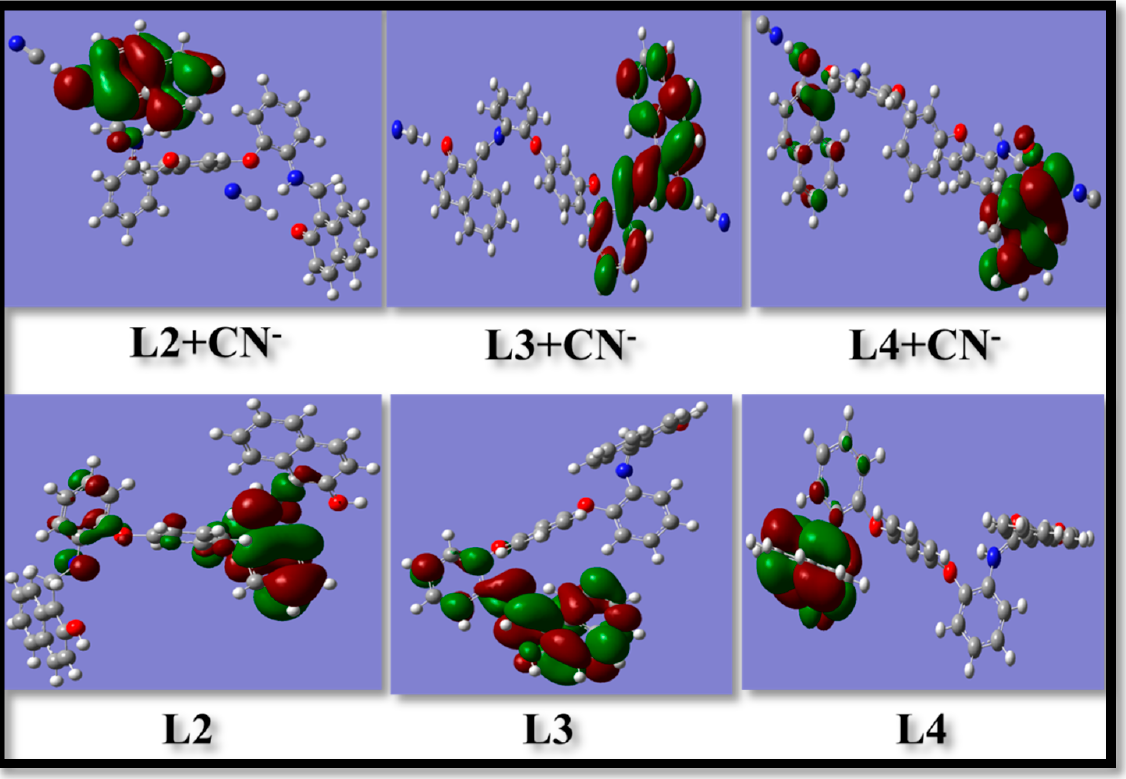
Figure 3. Optimized structure of receptors (L2–L4) and their cyanide complexes determined using DFT calculations (basis set-631-G). Table 1. Energy values (in a.u.) of receptors (L2–L4) and their complexes with CN − determined using DFT calculations.